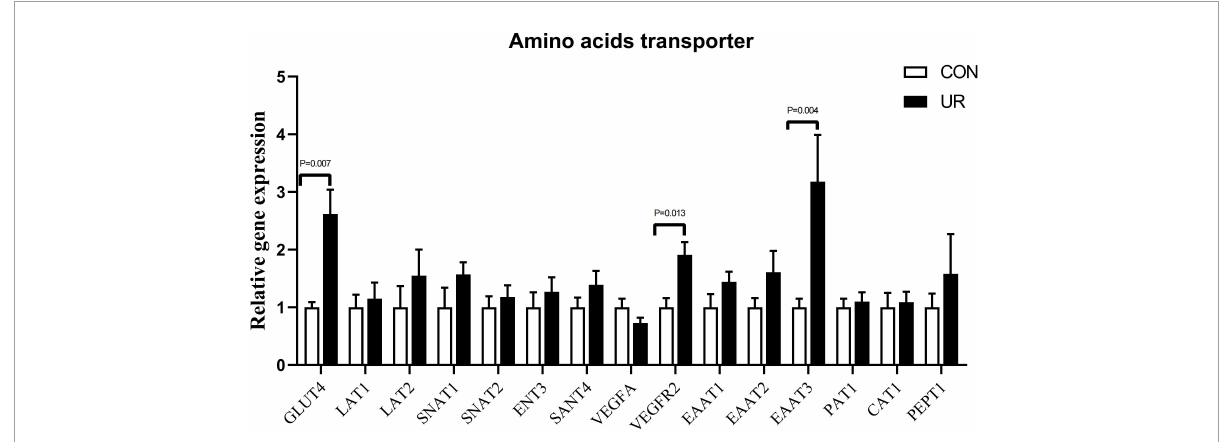
FIGURE1 Effects of UR on amino acids transporter in the placenta of sows. The data was presented as mean ± SEM, significantly different was considered when P < 0.05, n = 6